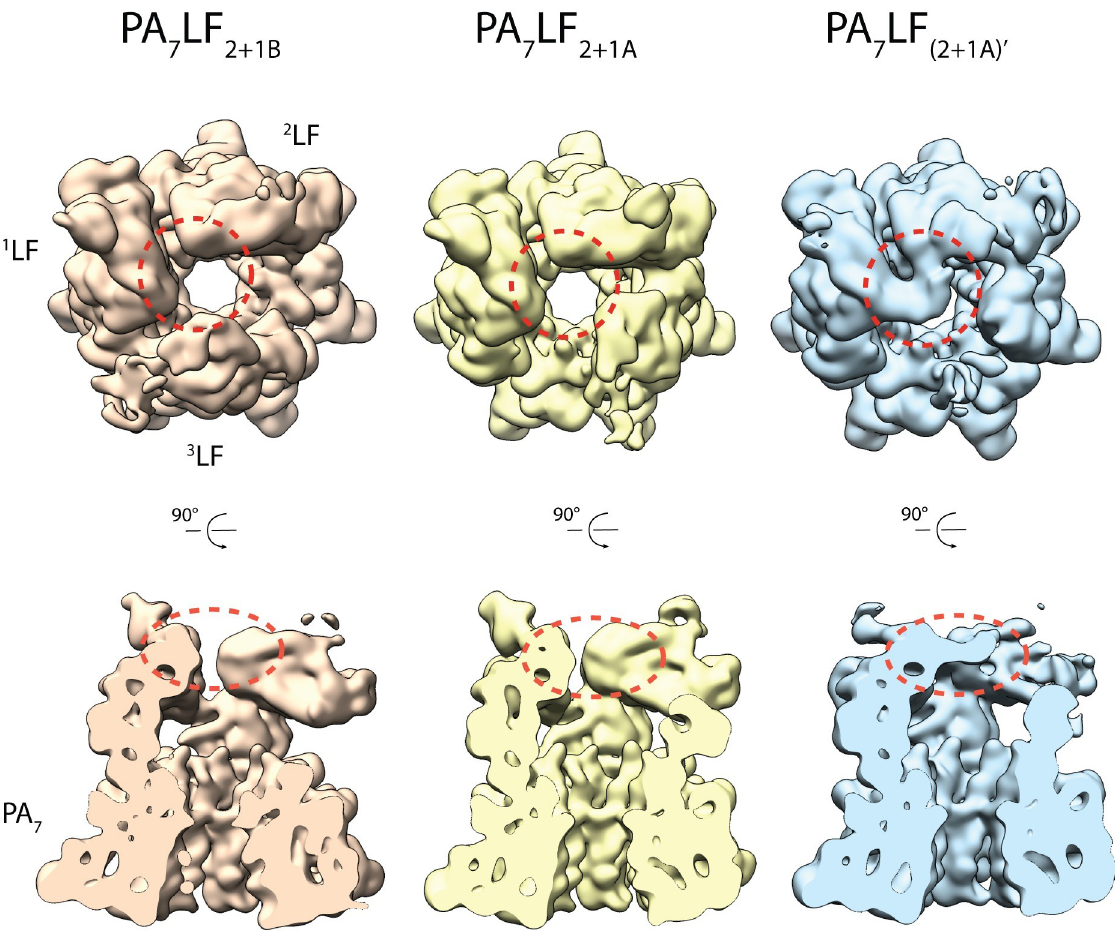
Fig 5. LFs can interact via their C-terminal domain. Top and side views of the low-passed filtered maps of the three PA 7 LF 3 complexes, with PA 7 LF 2+1B in orange, PA 7 LF 2+1A in yellow and PA 7 LF (2+1A)’ in light blue. Volumes are shown at the same threshold. While the three LFs interact in all structures via their N- and C-terminal domains in a head-to-tail manner, an additional interface was identified in the PA 7 LF (2+1A)’ reconstruction. Here, the C-terminal domains of 1 LF and 2 LF, interact with each other close to the central axis of the PA 7 LF 3 complex. This region is highlighted by dashed red circles. See also S2 Movie.